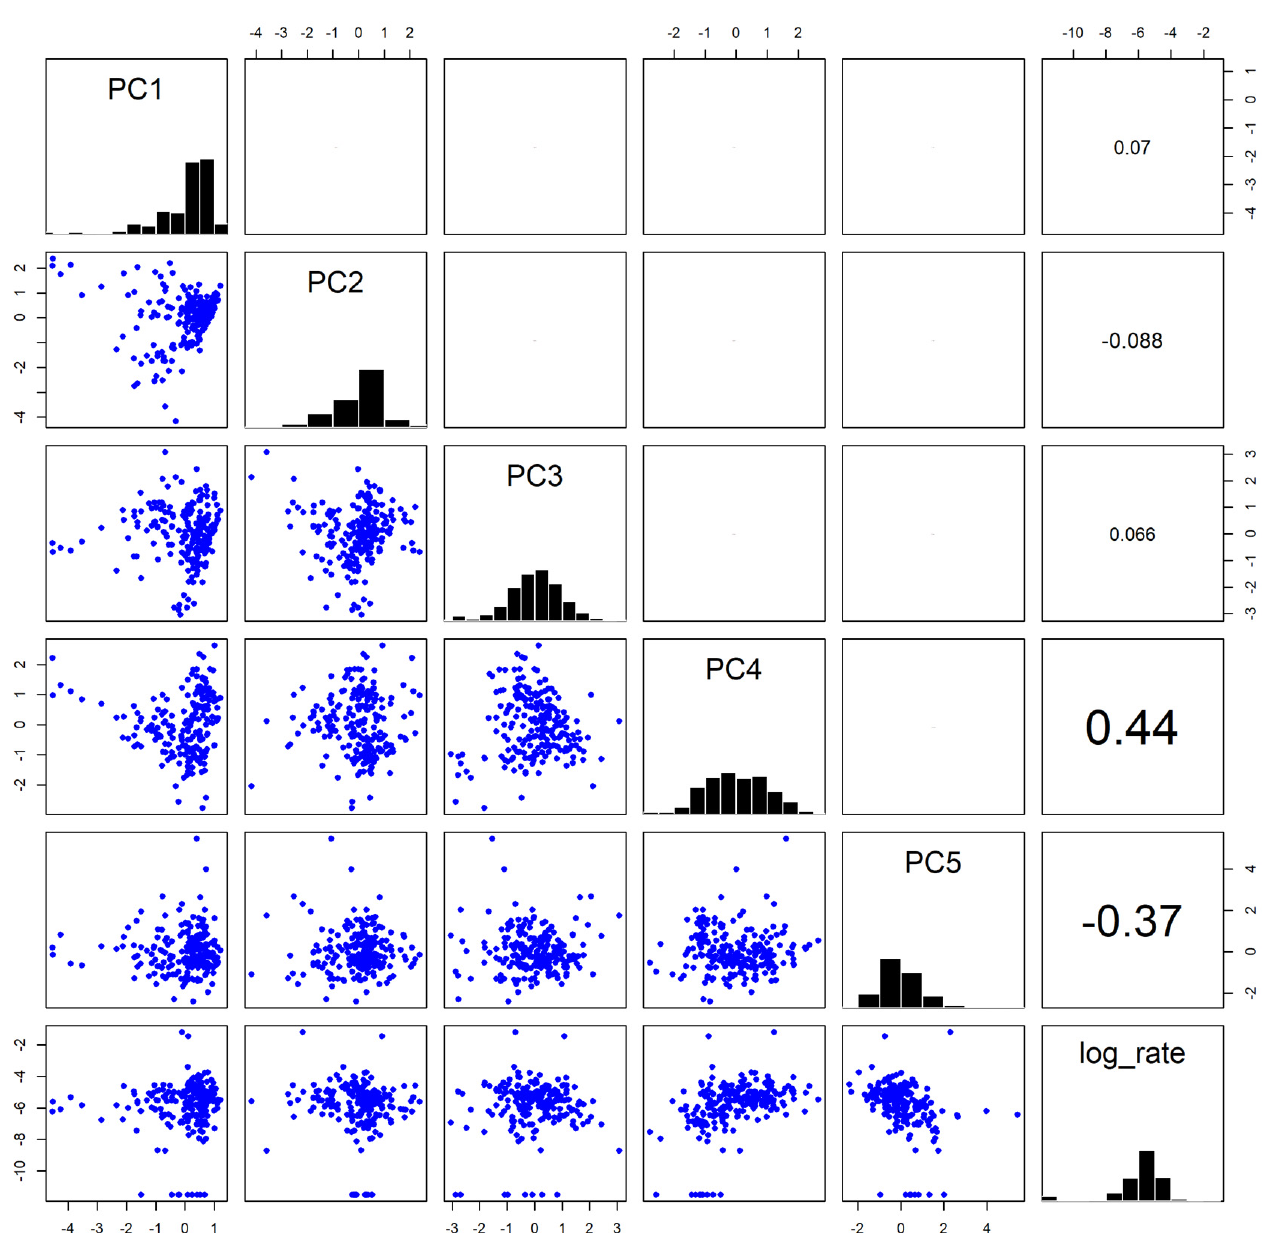
Figure A2. Relationships between principal component scores and log-mortality-rate. Note: The diagonal panels show the histograms of the principal components scores and log-mortality-rate; The lower panels show the scatterplots of the corresponding variables; The upper panels show correlation coefficients where the font size is proportional to the magnitude of the correlation coefficient.